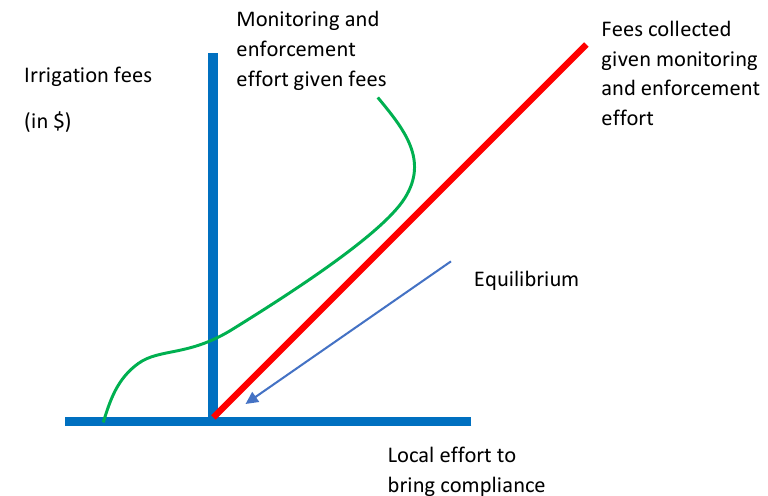
Figure 4. Hypothesised relationships between monitoring and enforcement given fees paid and fees paid given monitoring and enforcement, assuming a low local retention of fees.